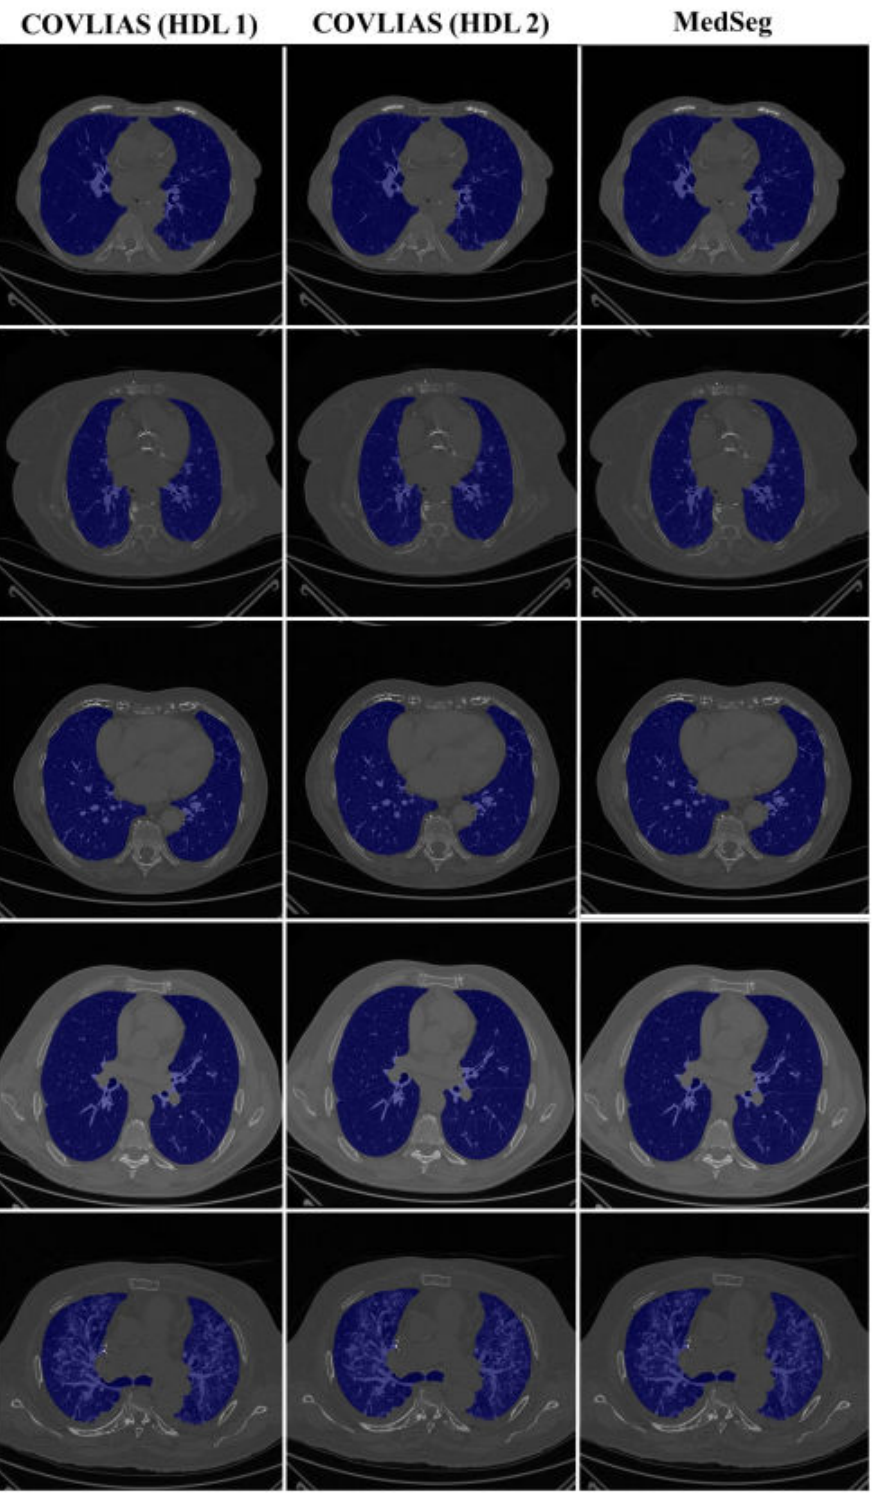
Figure 23. COVLIAS vs. MedSeg: Segmented mask (blue) on the non-COVID CT lung image (large